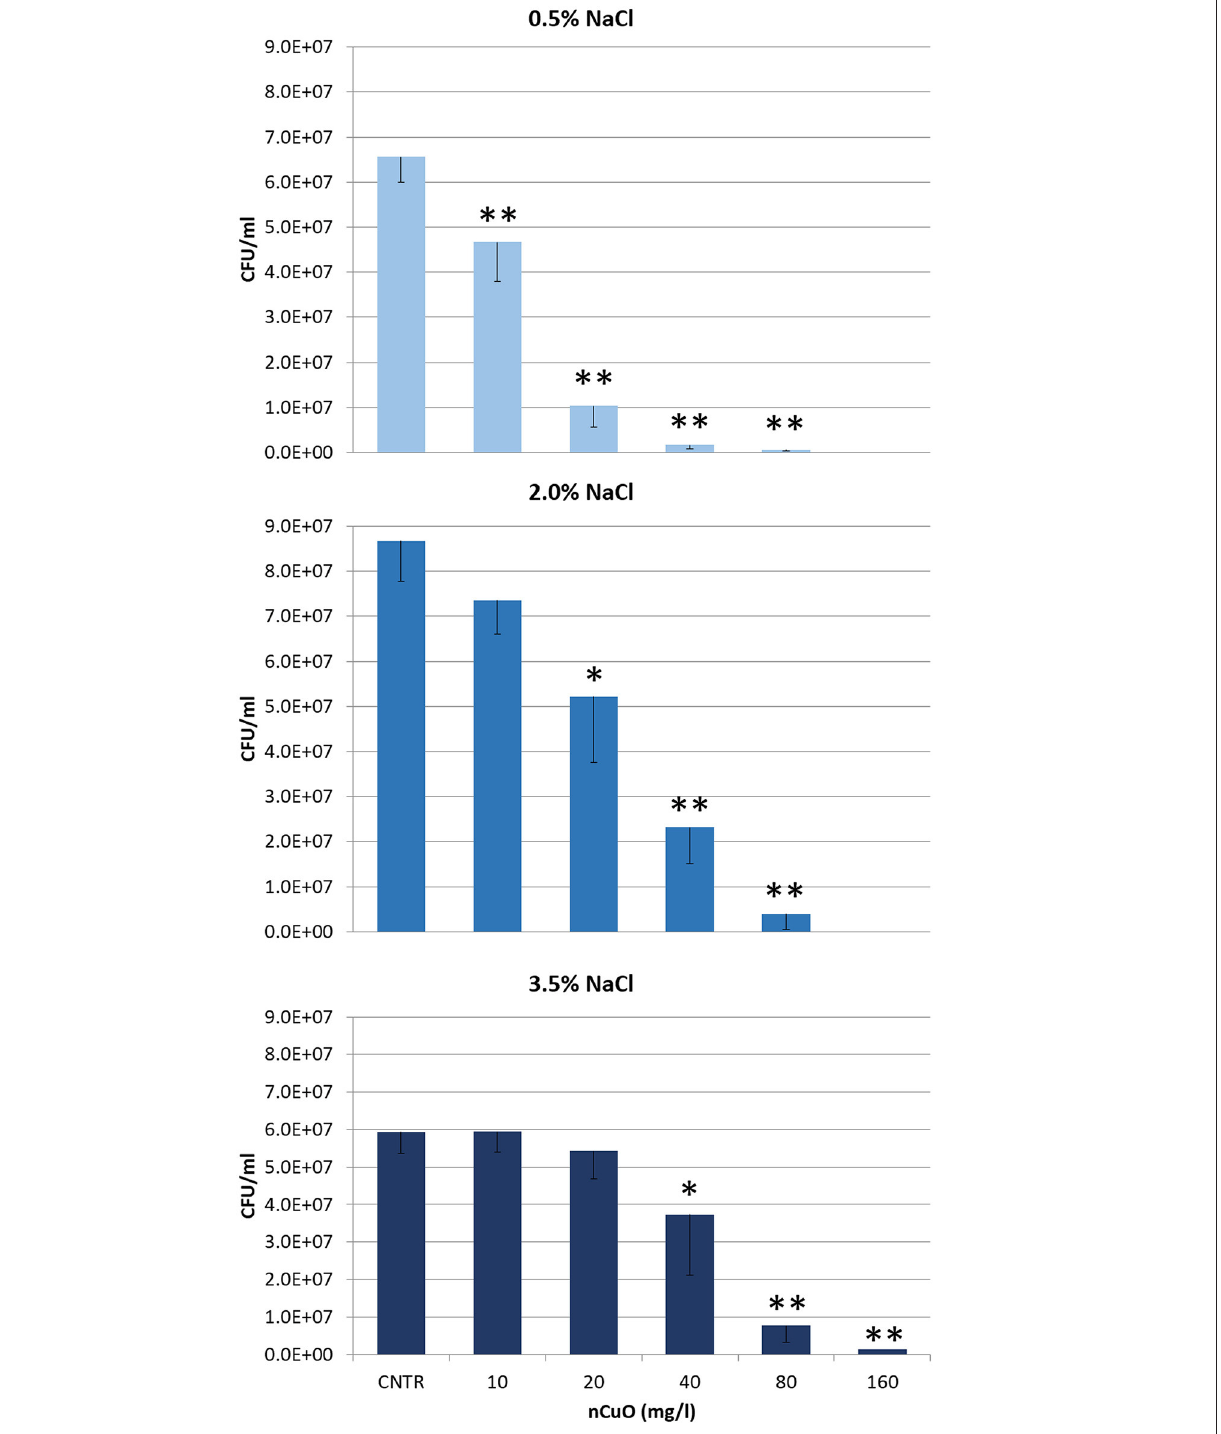
FIGURE 3 | Mean number of CFU/ml (CFU = Colony Forming Unit) of Vibrio anguillarum after 6-h exposure to different concentrations of CuO NPs in exposure medium at three different salinities ( T = 25 ◦ C, 0.5-2.0-3.5% NaCl). Values represent the mean of three independent trials; error bars represent standard deviation. Significant reduction of CFU/ml compared to control, based on post hoc t -test, are indicated with asterisks (* p < 0.05; ** p < 0.01).